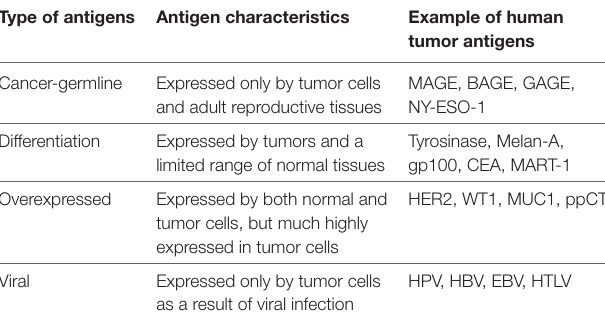
TABLe 1 | Classification of tumor-associated antigens. Type of antigens Antigen